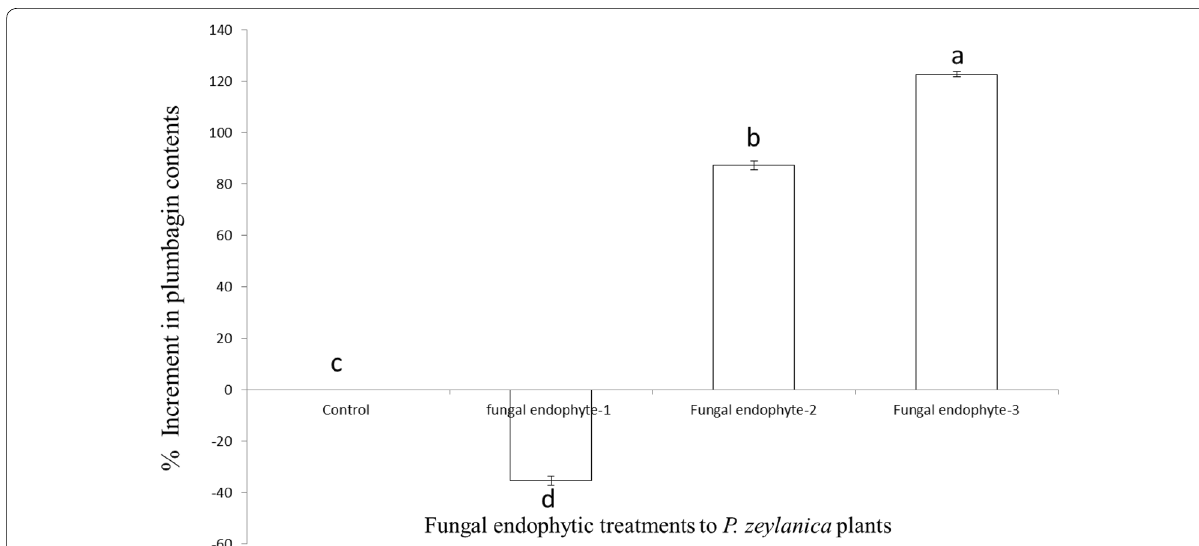
Fig. 1 Percent enhancement of plumbagin contents in Plumbago zeylanica plants with the treatment of fungal endophytes. # Different letters over the error bars indicate the significant level of difference at 0.05 level of significance